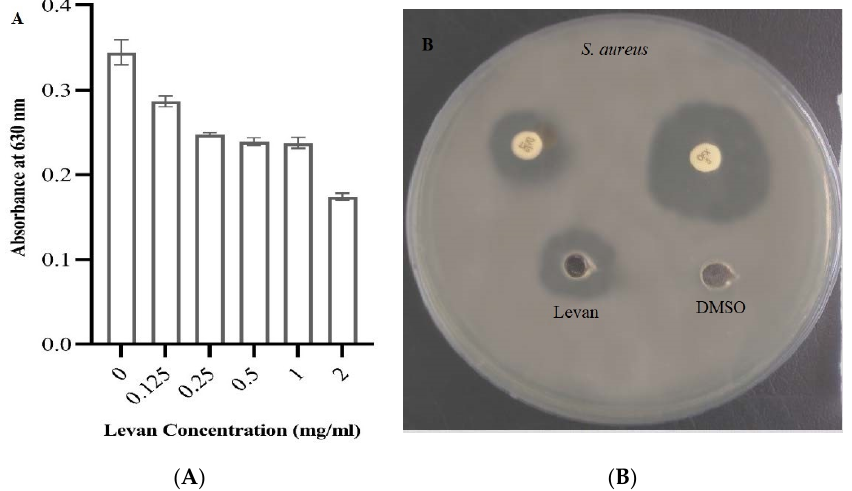
Figure 5. ( A ) Inhibition of P. aeruginosa biofilm formation using levan polymer and ( B ) antibacterial activity of levan against S. aureus (ATCC